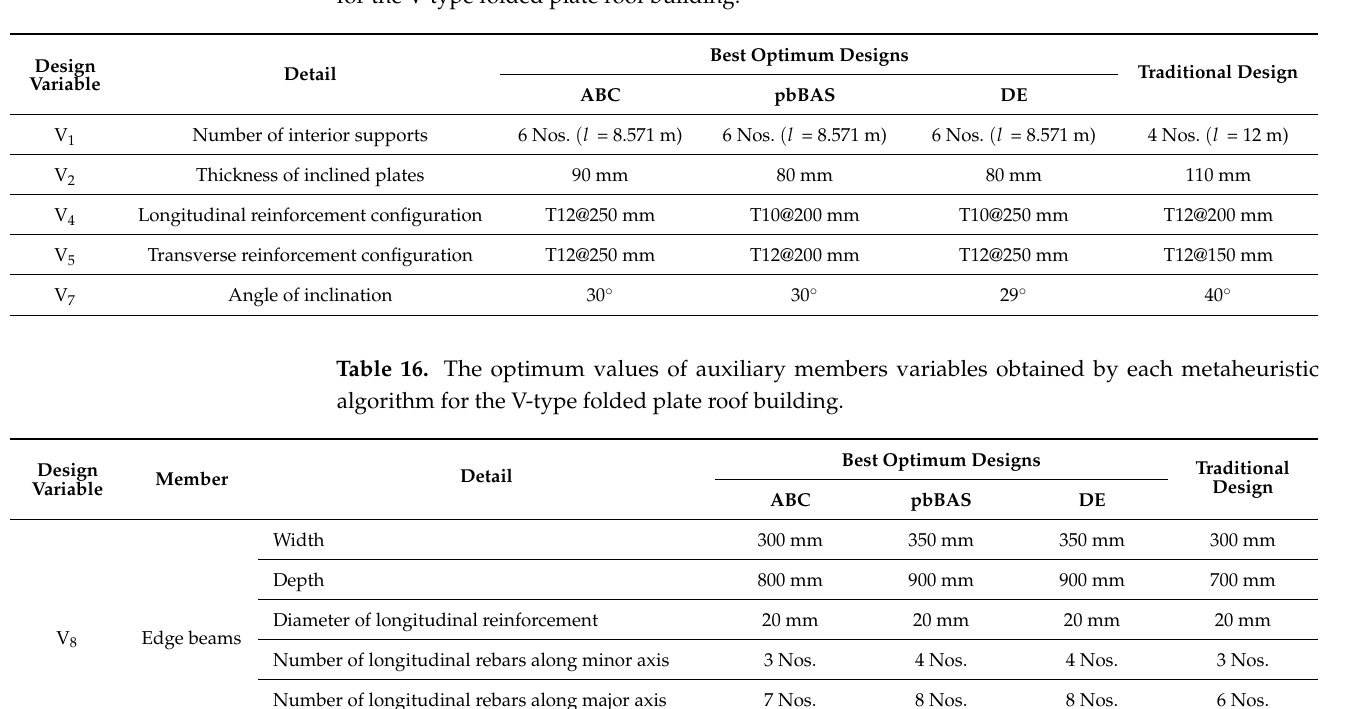
Figure 15. Box plot of the results achieved by each metaheuristic algorithm after 10 runs for the V-type folded plate roof problem.